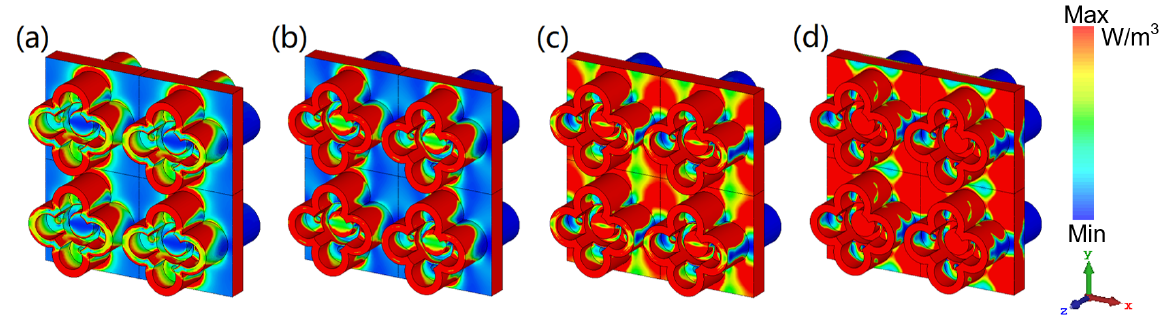
Figure 5. The power loss density of water layer at ( a ) 6.86 GHz; ( b ) 16.34 GHz; ( c ) 24.72 GHz; ( d ) 40 GHz.